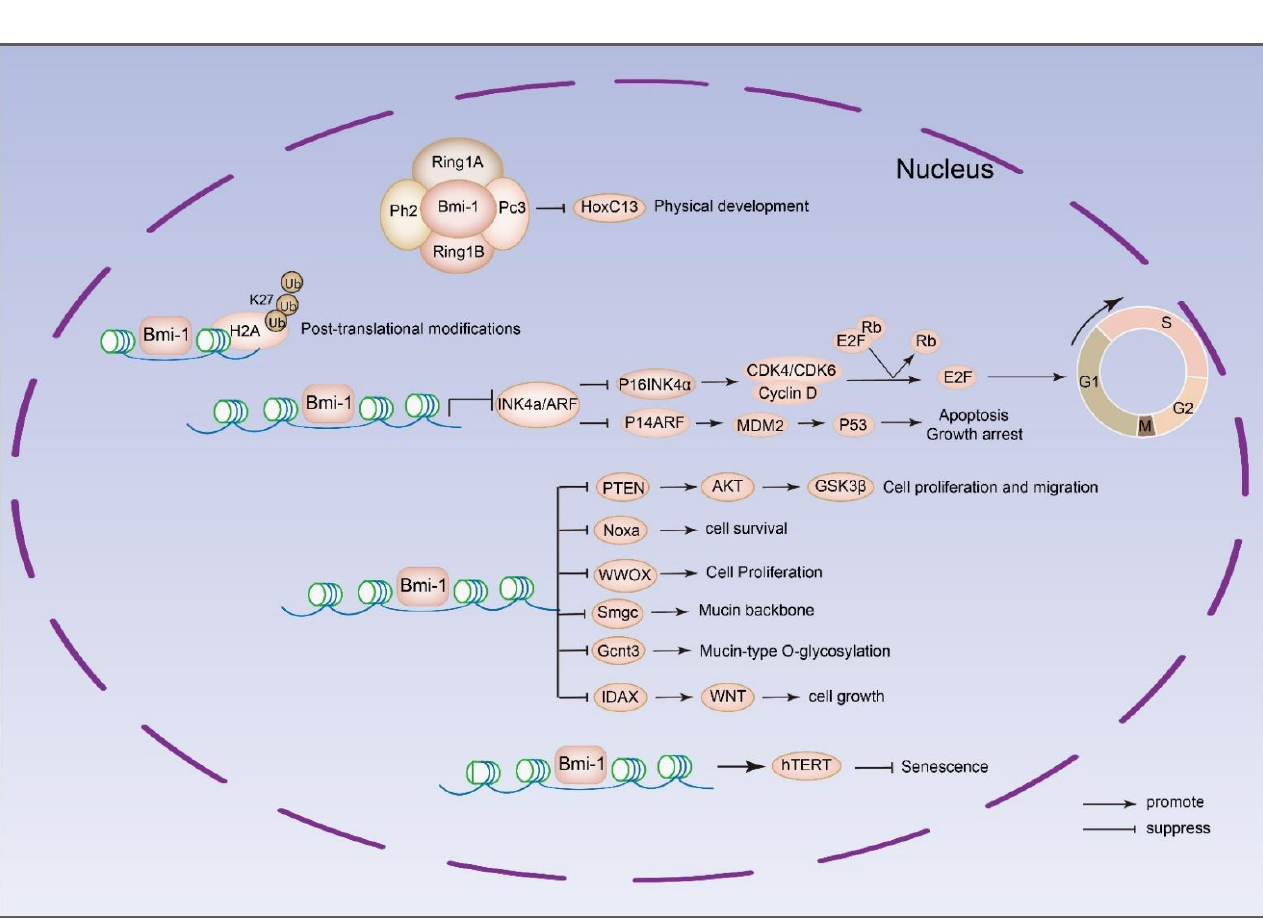
Figure 2. Downstream genes directly regulated by Bmi-1. Bmi-1 can enhance H2A ubiquitination and bind to the promoter of HoxC13 to reduce the expression of HoxC13 in HeLa cells [77]. The most classic downstream target of Bmi-1 is INK4a/ARF. The tumor suppressor gene INK4a/ARF can encode two regulatory genes: p16 INK4a and p14 ARF ( p19 ARF in mice). P16 INK4a arrests cells in G0/G1 phase through cyclinD-CDK4/6-pRb-E2F. p14 ARF regulates the cell apoptosis through MDM2-p53 pathway [76]. Bmi-1 can regulate the development of colon cancer by negatively regulating the expression level of PTEN and then activating the Akt/GSK3β axis [78]. Bmi-1 regulates memory CD4 T cell survival via repression of the proapoptotic BH3-only protein Noxa gene [80]. Bmi-1 regulates cell fate via transcriptional repression tumor suppressor WW Domain Containing Oxidoreductase (WWOX) in small-cell lung cancer cells [81]. Bmi-1 suppresses the expression of Smgc gene and Gcnt3 gene [82]. Bmi-1 activates Wnt signaling in colon cancer by negatively regulating the Wnt antagonist IDAX [83]. Bmi-1 can also transcriptionally positively regulate human telomerase reverse transcriptase (hTERT) to block senescence in human mammary epithelial cells [79].